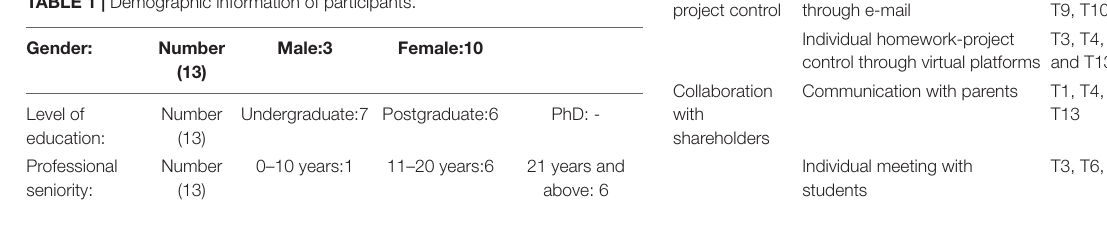
TABLE 1 | Demographic information of participants.